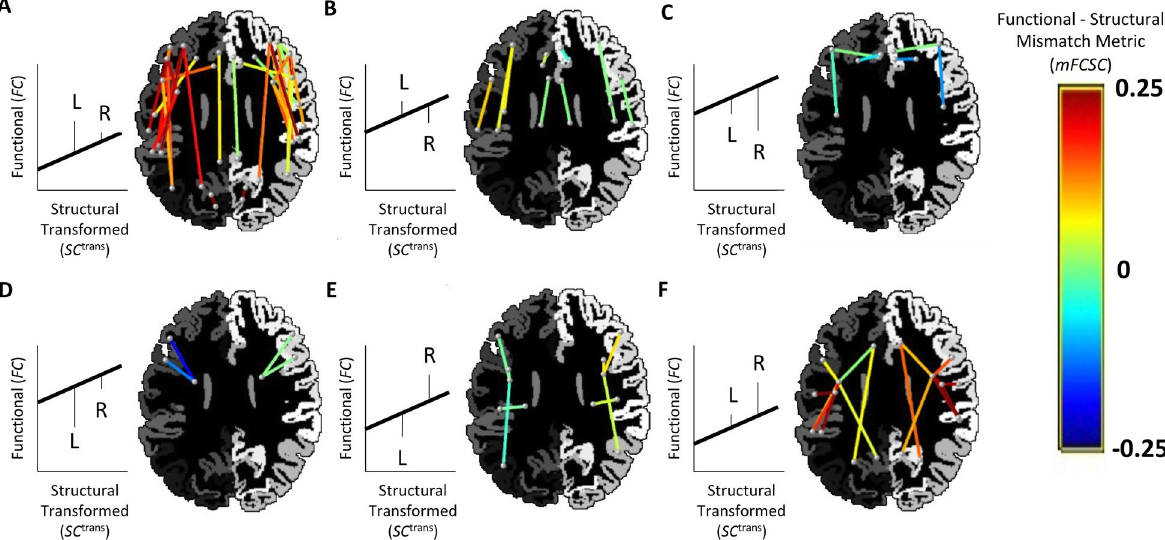
Figure 3. Bilateral pairs with difference between the FC-SC mismatch values in left and right unilateral connections. Bilateral pairs that had significant difference between left and right mFCSC values are shown ( p < 0.00006; Bonferroni corrected with alpha set to 0.05). Each pair is represented by two lines, for left- and right-hemisphere, respectively. The dots at the edges of the lines represent the connected regions and are positioned at their centres. An axial slice of the parcellation for a representative brain serves as a background (but note that the regions represented by the dots might be superior or inferior to that plane). The FC-SC mismatch value of each connection is given by the line colour. The bilateral pairs are divided into six panels ( A–F ) according to the relation between the average value of left mFCSC and the average value of right stronger in the right unilateral connection (the vertical line denoted by “R” is to the right of the “L” line), but this is not to indicate the typical scenario in the data. L left unilateral connection, R right unilateral